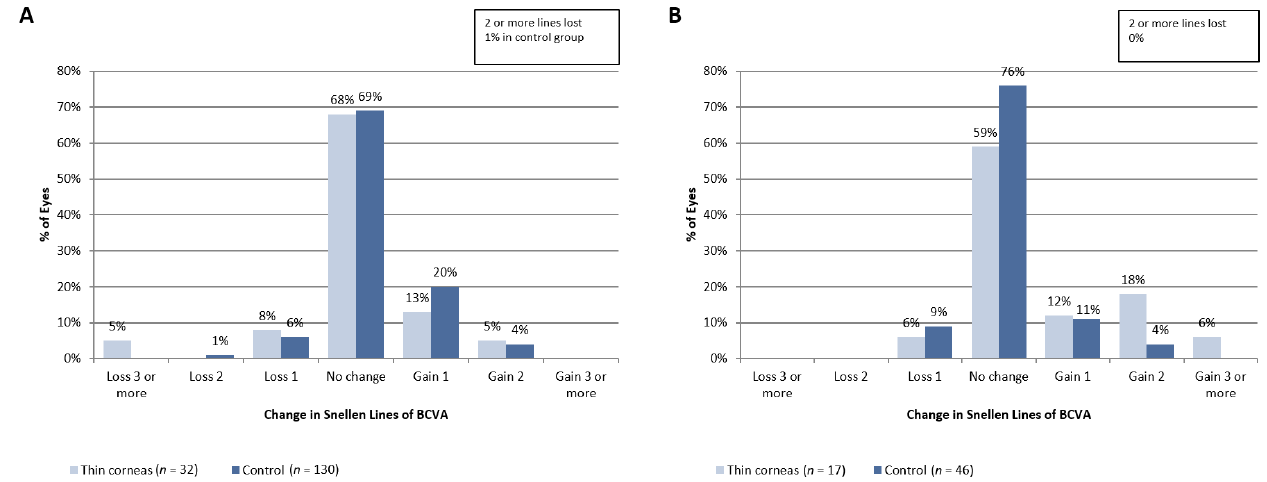
Figure 2. Change in BCVA at 3 months ( A ) and 6 months ( B ) after the procedure compared to preoperative BCVA. Notes: A—evaluation at 3 months after surgery; B—evaluation at 6